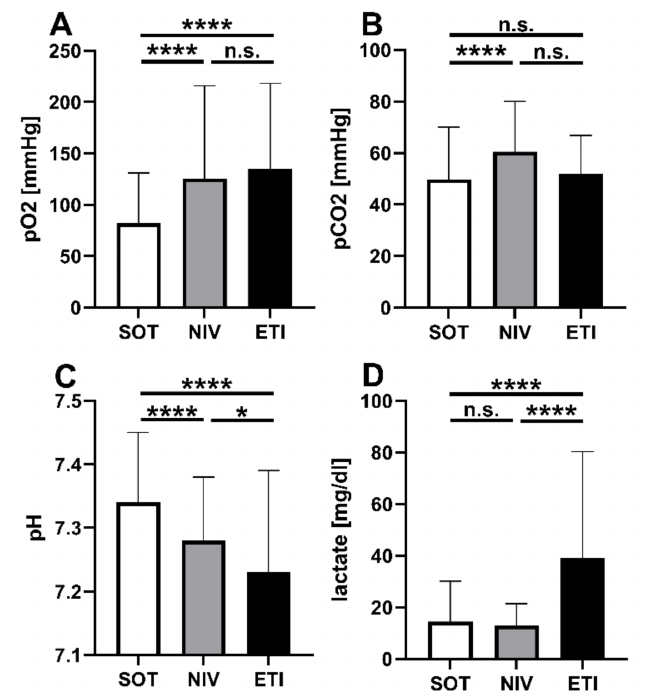
Figure 3. First blood gas analysis after hospital admission. Arterial or capillary blood gas analysis after hospital admission: ( A ) oxygenation stated as pO 2 = partial pressure of O 2 ; ( B ) elimination of CO 2 stated as pCO 2 = partial pressure of carbon dioxide; ( C ) acid-base status stated as pH value; ( D ) plasma lactate levels. Data are plotted as mean and standard deviation; p > 0.05 = not significant (n.s.), p < 0.05 = *, p < 0.0001 = ****. Abbreviations: SOT = standard oxygen therapy, NIV = non-invasive ventilation, ETI = endotracheal intubation.